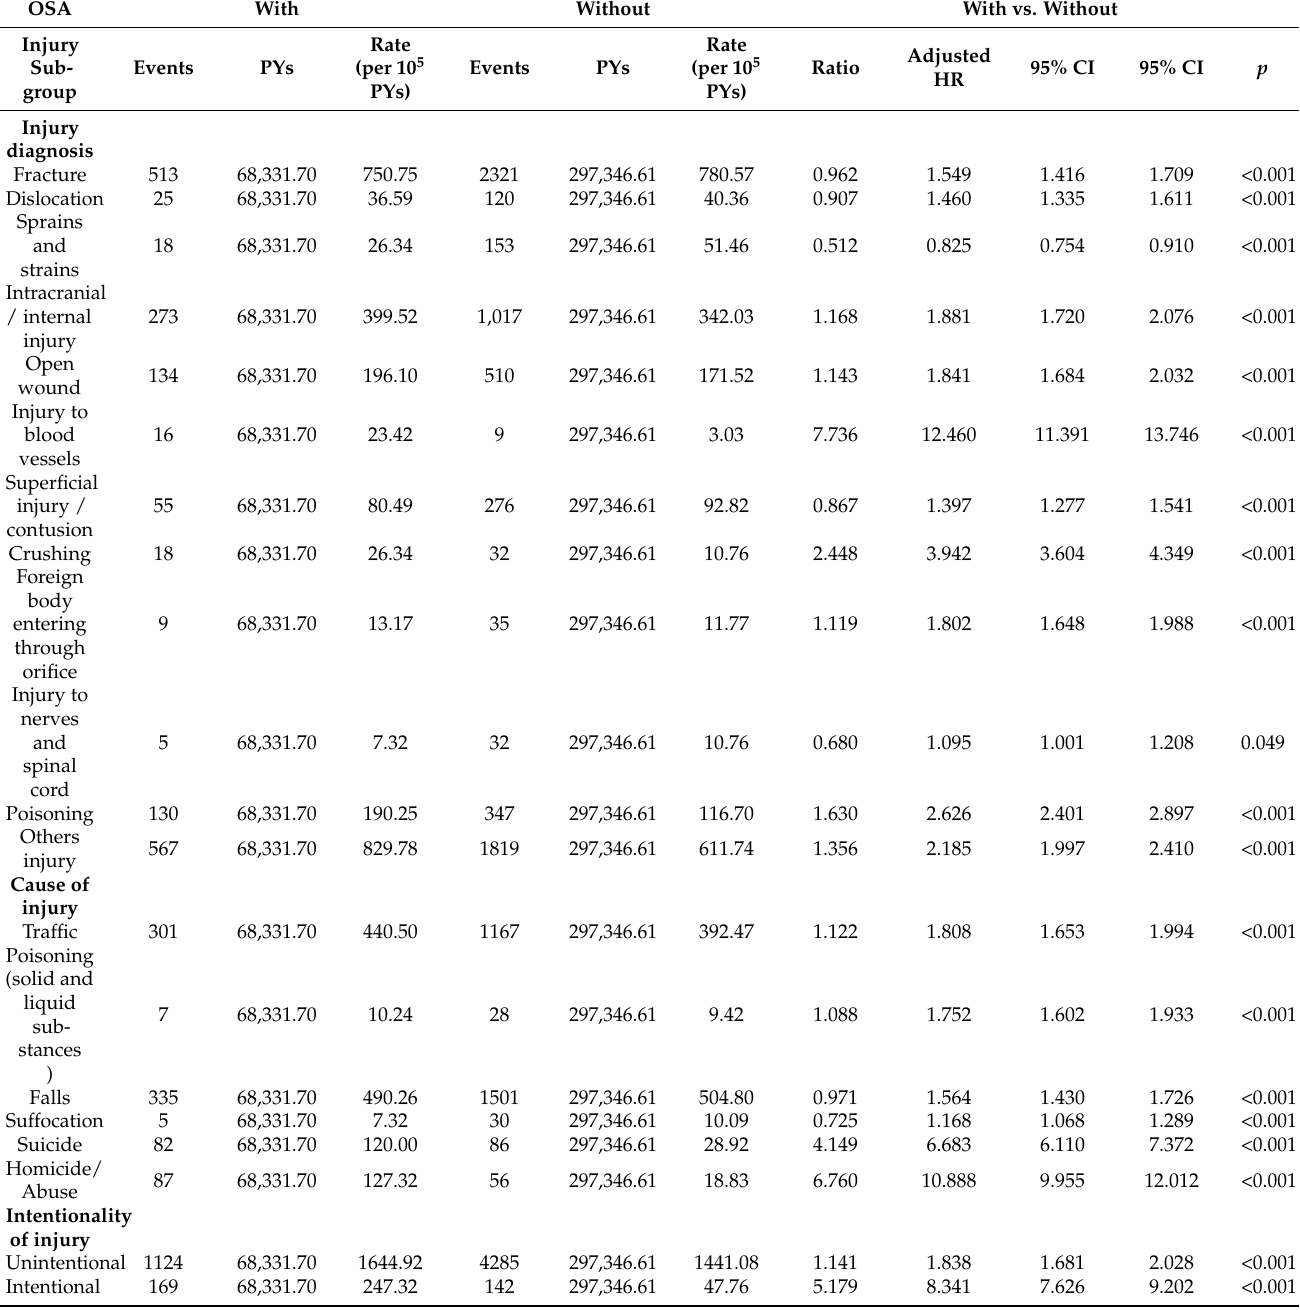
Table 3. Factors of injury subgroup by using Cox